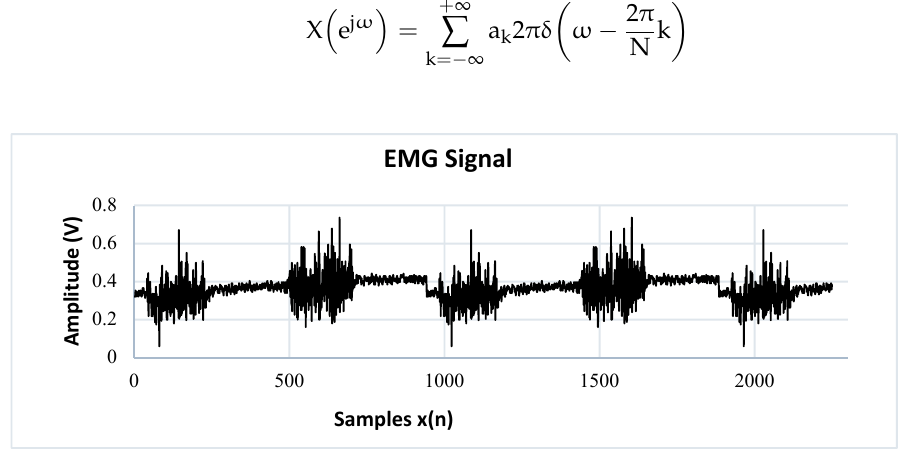
Figure 8. Filtered EMG signal.